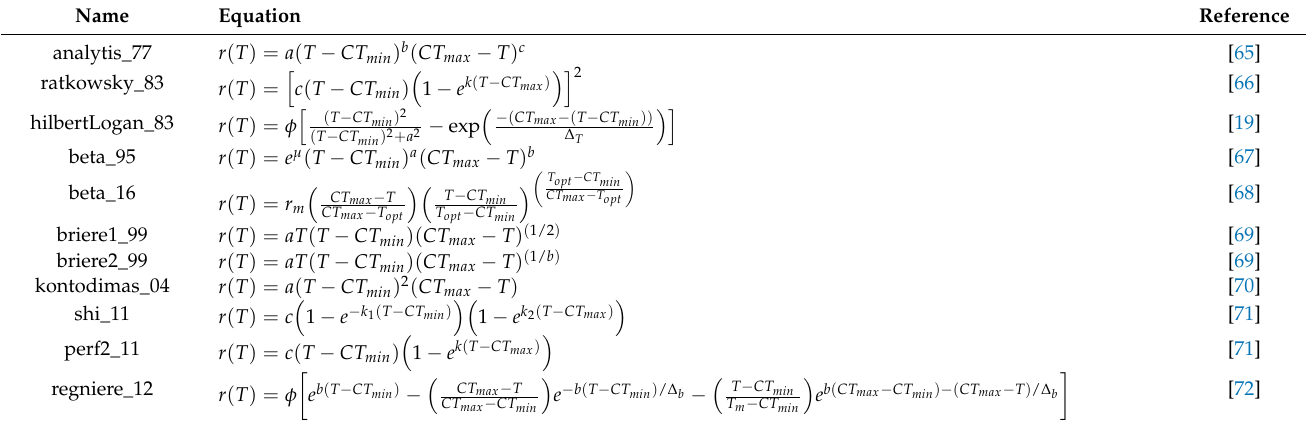
Table 2. Nonlinear models used to relate development rate with temperature. r ( T ) corresponds to development rate, T corresponds to temperature, a , b , c , k 1 , k 2 corresponds to constants, T opt corresponds to the optimal temperature for development, CT min and CT max correspond to the minimal and maximal critical thresholds for development. Models were chosen because they allow the computation of T opt , CT min and CT max